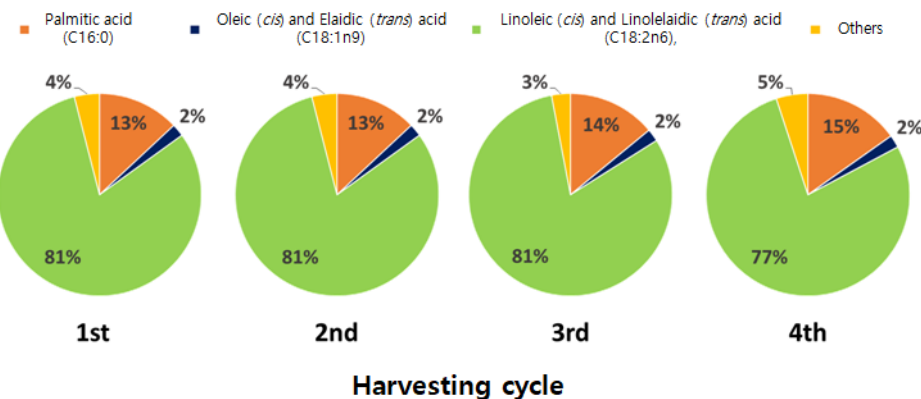
Figure 2. Changes in the FA levels in shiitake mushrooms based on the harvesting cycle. The results indicate the mean value of the samples produced using both Korean and Chinese substrates.